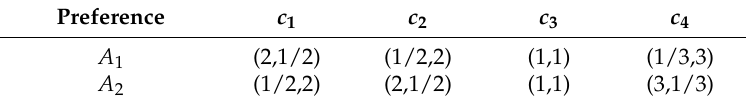
Table 1. The minimal situation for the preference relation between A 1 and A 2 .